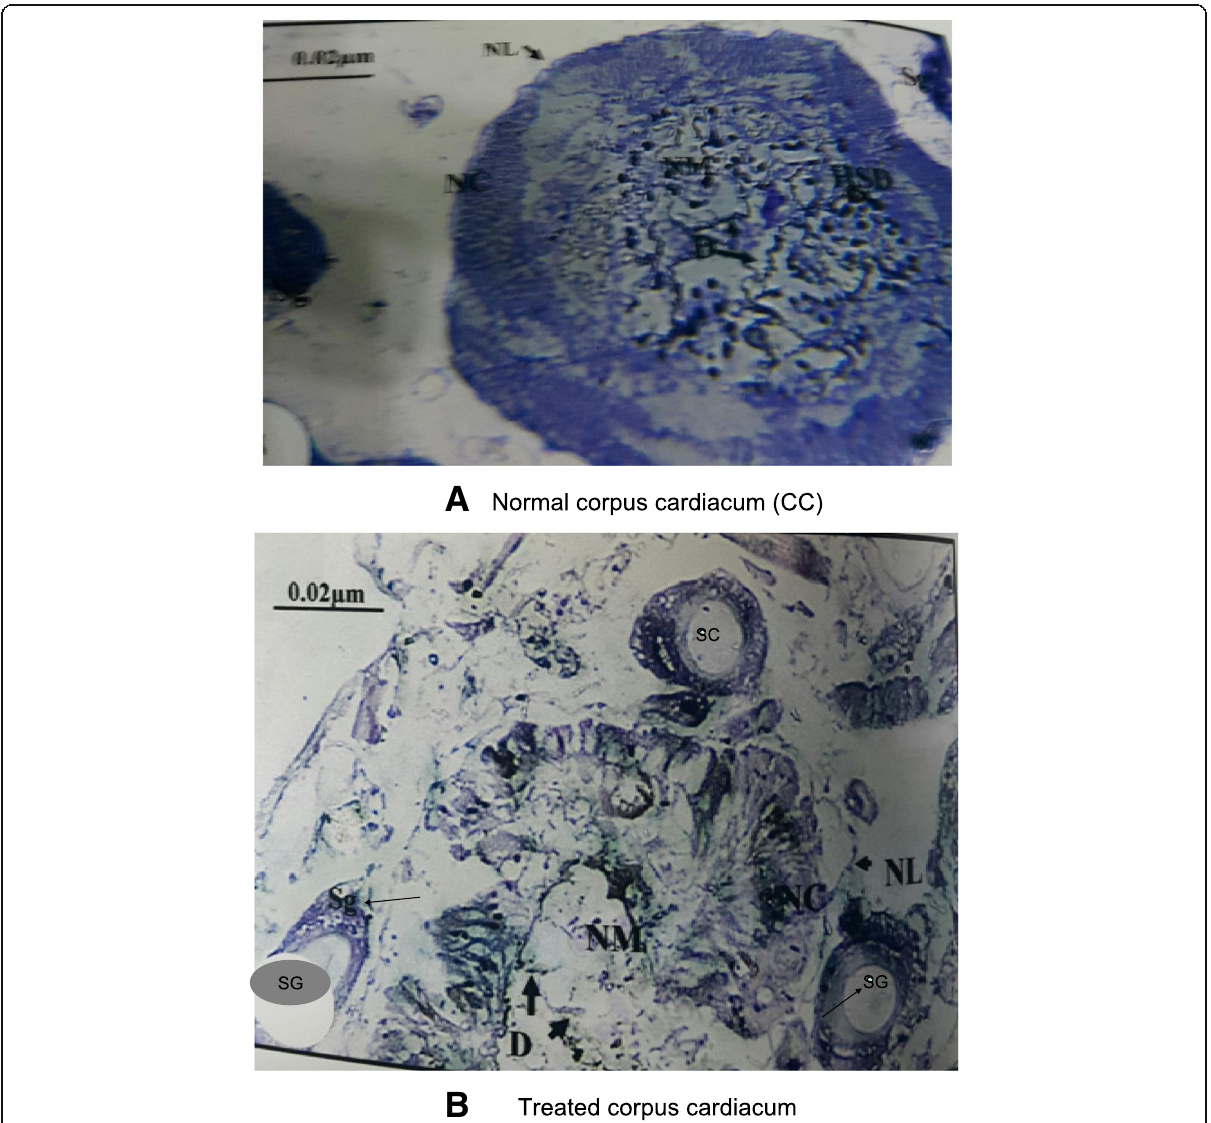
Fig. 3 a Normal corpus cardiacum (CC). b Treated corpus cardiacum. Semi-thin sections by a light microscope in different parts in the endocrine organs in larvae of the potato tuber moth Phthorimeae operculella ( a normal and b treated larvae). Abbreviations: NSC neurosecretory cells in medial cerebral, NV nerve, CC corpora cardiac, NC nerve cells, NL neural lamella, D dendrites, HS droplets of secretion, SG salivary gland, HSD hormone secretion droplets, NM neuropile mass, CA corpus allatum, AO aorta, Tr tracheoles, Pg prothoracic gland, C cell body, M membrane, BM basal